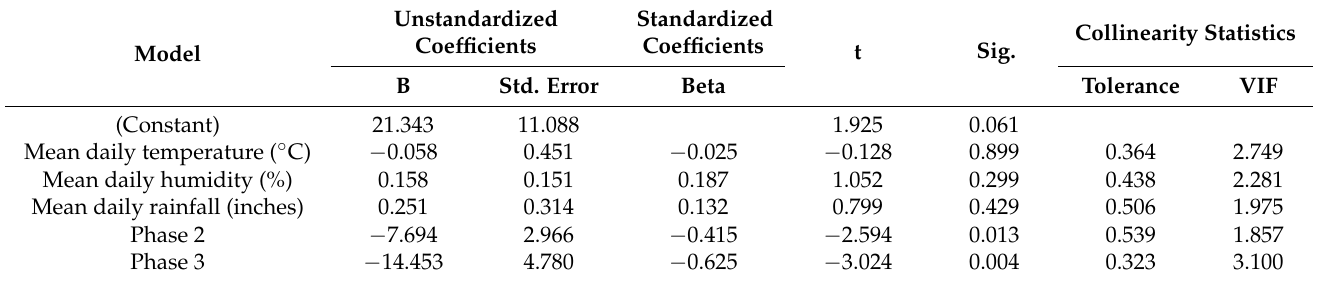
Table 1. Multiple linear regression analysis for PM 2.5 air pollution over the three-phase approach to lifting COVID-19 restrictions in